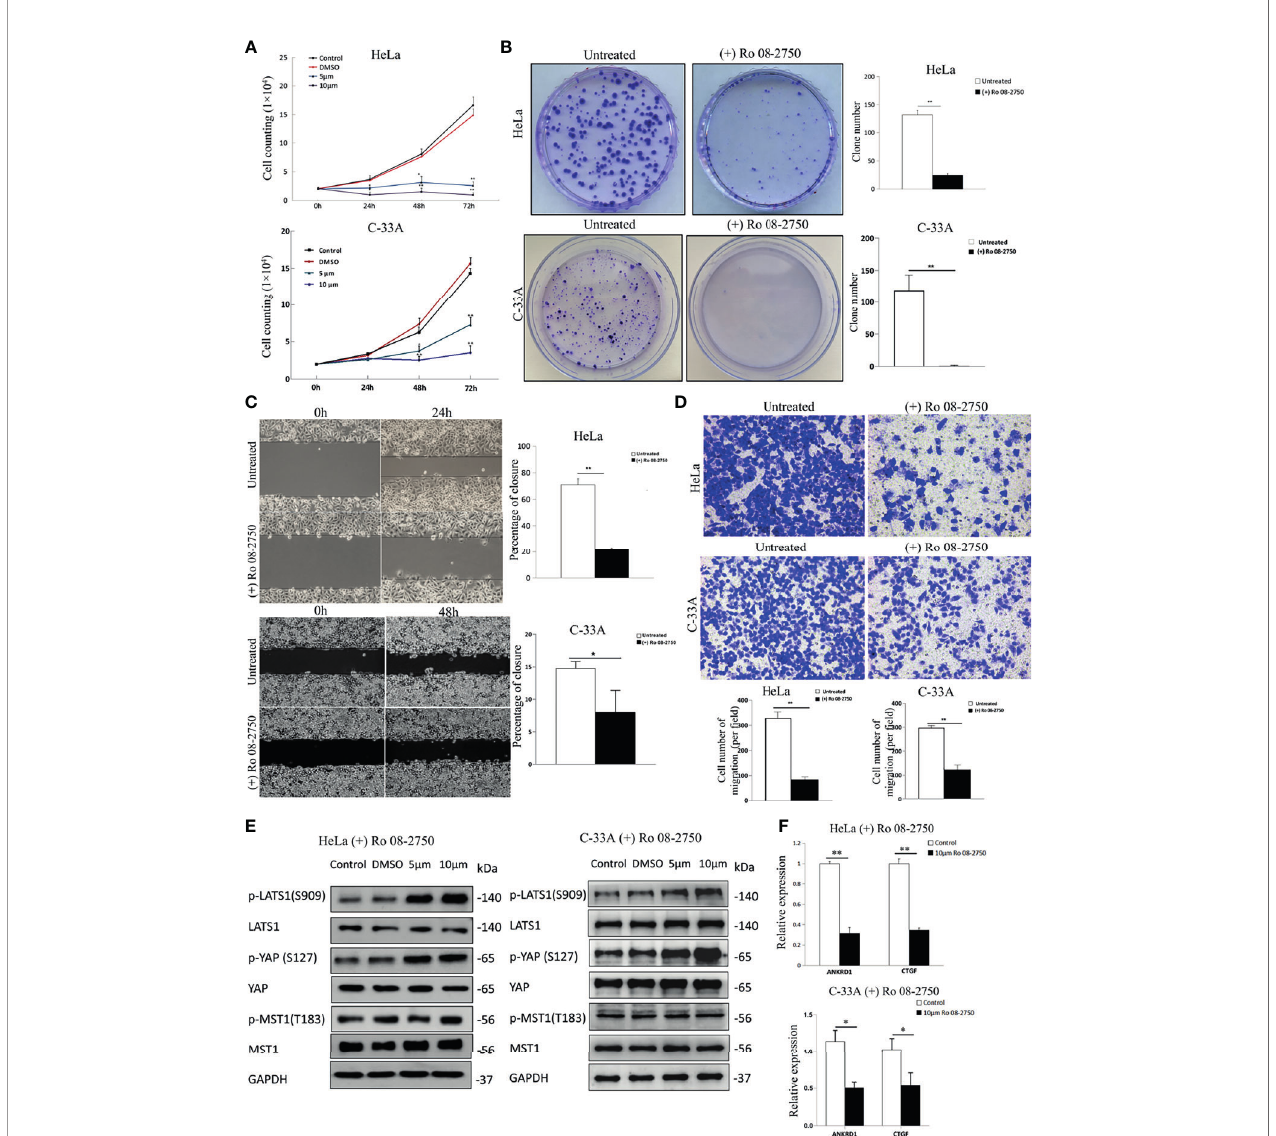
FIGURE 2 | Inhibition of NGF suppresses the proliferation and migration of cervical cancer cells effectively. (A) The numbers of HeLa and C-33A cells were treated with DMSO, Ro 08-2750 (5 m M or 10 m M) in media containing 10% FBS; the numbers of cells every 24 h for 72 h were counted. (B) Representative images of a colony formation assay of HeLa and C-33A cells treated with or without 10 m M Ro 08-2750 for 3 weeks (left panel). The results of three independent colony formation assay experiments were quanti fi ed (right panel). (C) Representative images of a wound healing assay of cervical cancer cell lines treated with or without 10 m M Ro 08-2750 for 24 h (HeLa cells) or 48 h (C-33A cells) and incubated in medium containing 10% serum (left panel). The extent of wound closure estimated from three independent experiments was quanti fi ed (right panel). (D) Representative images of transwell assays of cervical cancer cell lines treated with or without 10 m M Ro 08-2750 for 24 h and incubated in medium containing 10% serum (top panel). The extent of the cell number of migration (per fi eld) estimated from three independent experiments was quanti fi ed (bottom panel). (E) Representative Western blot analysis of lysate from HeLa and C-33A cells treated with solvent (DMSO, 24 h) or Ro 08-2750 (5 or 10 m M, 24h). GAPDH was used as a loading control. (F) Total RNA expression of YAP target genes in cervical cancer cell lines treated with or without 10 m M Ro 08-2750. All results are the mean of at least three independent experiments, with each performed in triplicate. Error bars represent SDs; *P < 0.05; **P <